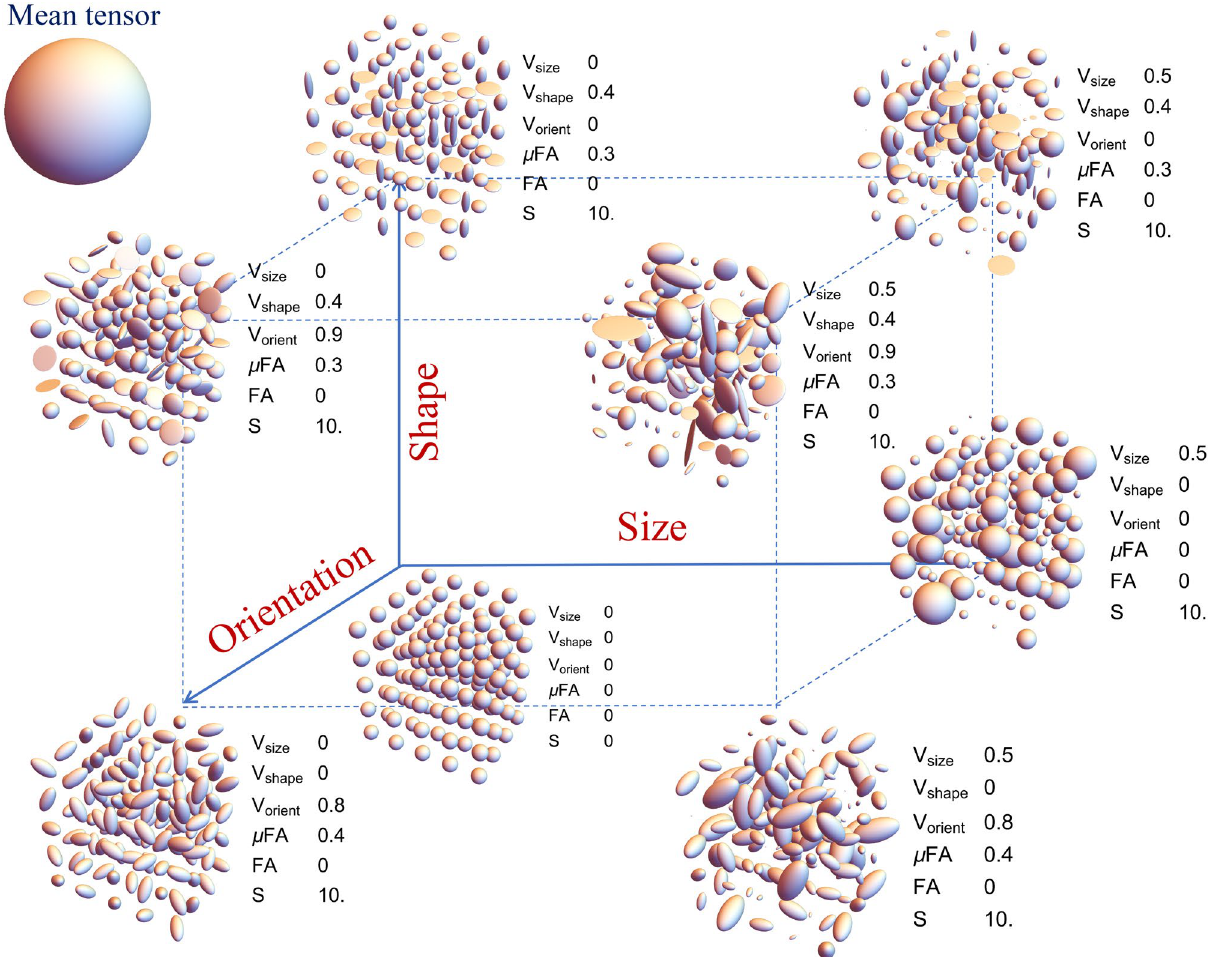
Figure 9. Various parametric stains depicting the shape, size and orientation heterogeneity for a macroscopically isotropic mean diffusion tensor shown on the upper left corner. The DTD and calculated values of the various stains are shown at various points in the 3D grid. Size axis refers to heterogeneity in the trace of the diffusion tensors, shape axis refers to heterogeneity in the shapes of the diffusion tensors, and the